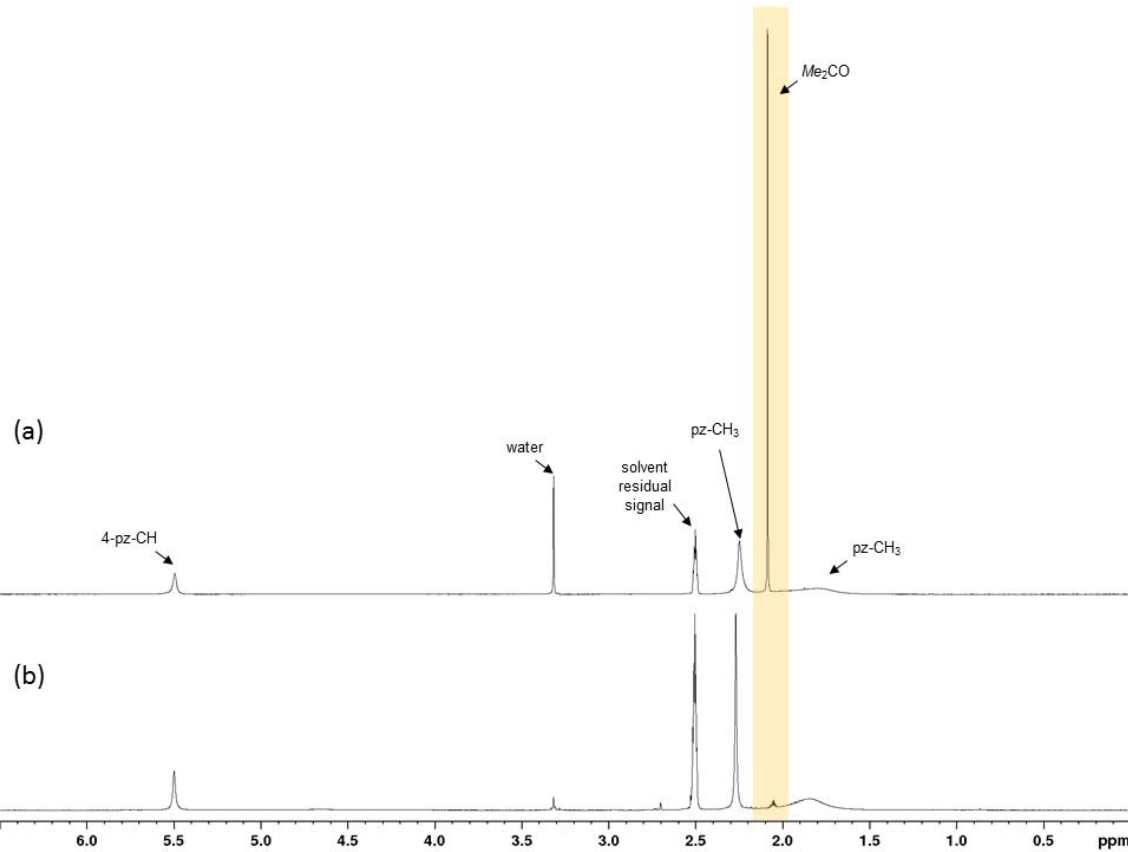
: (a) at the sample preparation, (b) after several days stored at 6